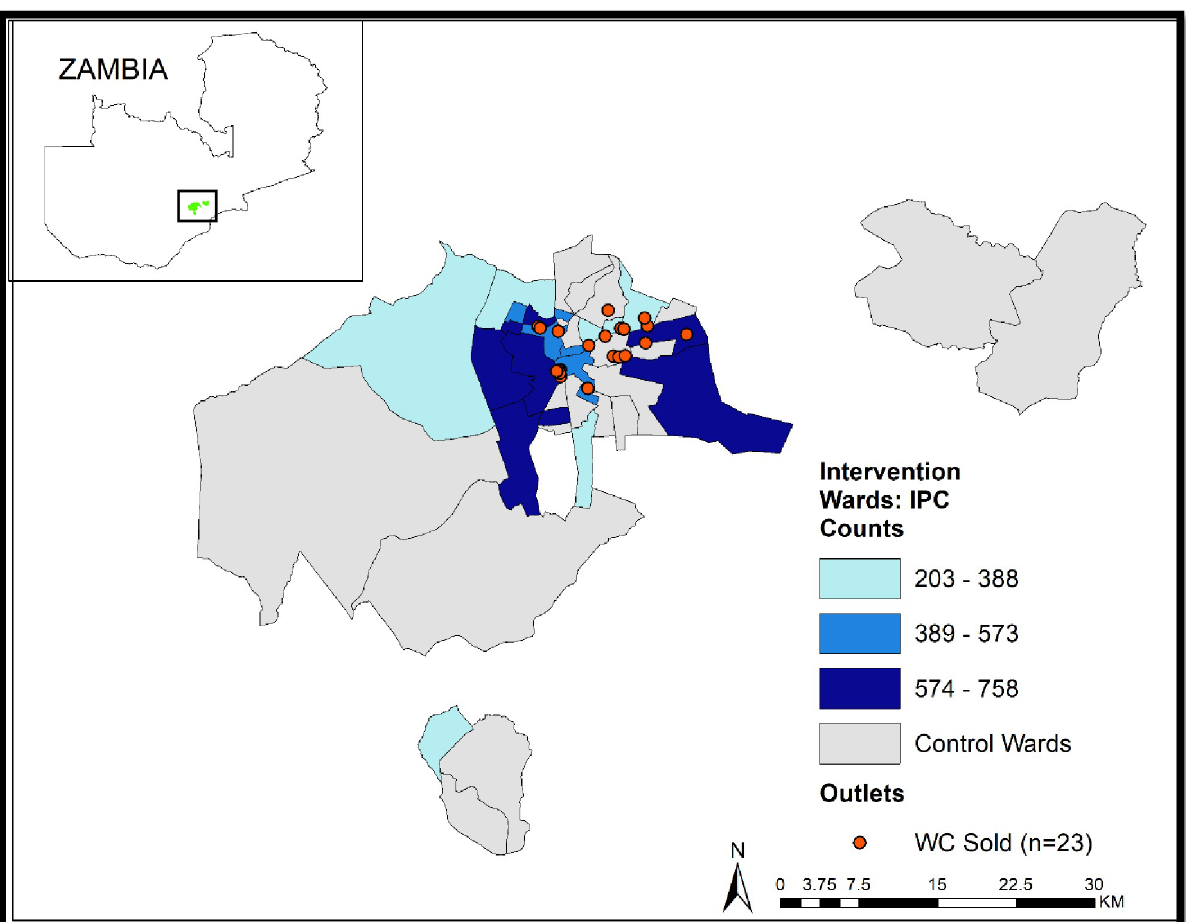
Fig 4. Map of IPC coverage per intervention ward and location of outlets selling the WC (as detected during a mystery shopper activity).